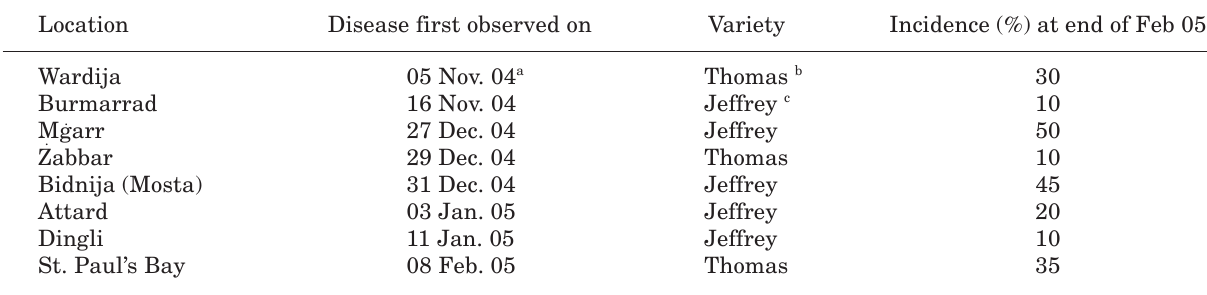
Table 1. Locations in which FORL was observed from November 2004 to February 2005 in Malta. Location Disease first observed